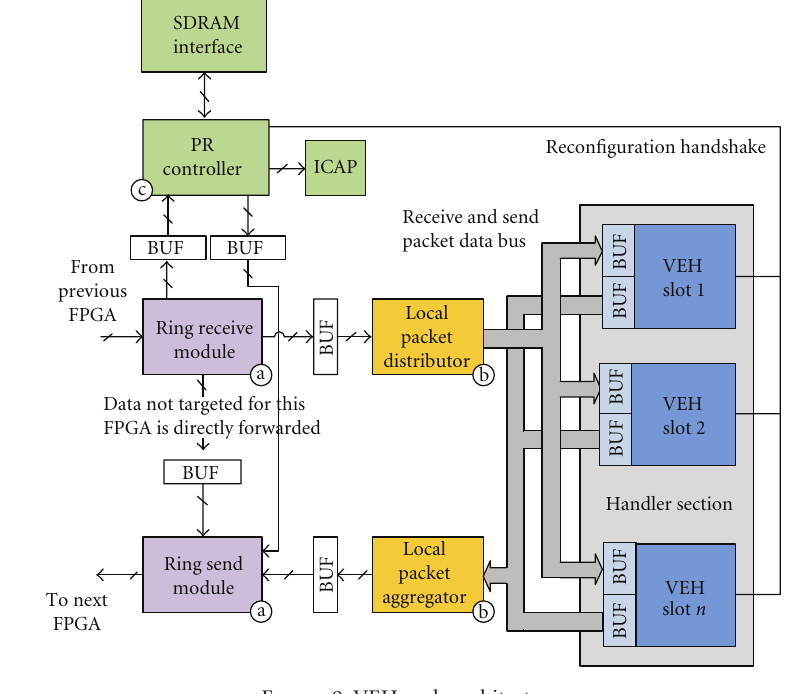
Figure 9: VEH node architecture.